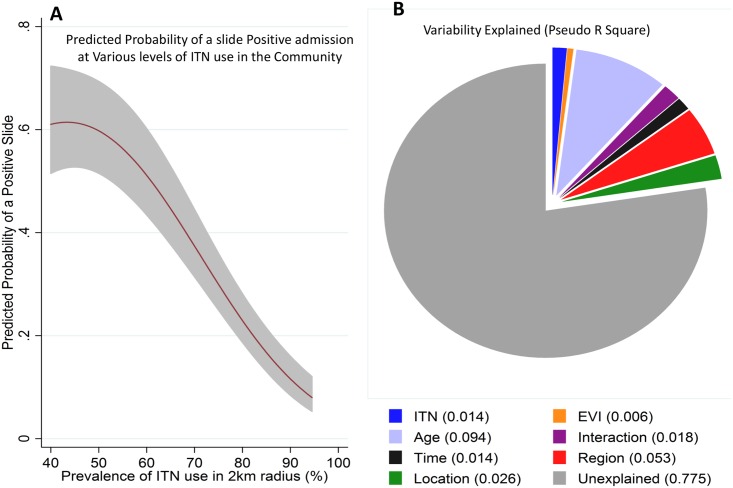
Regression model prediction and variability explained by the predictors of the model.Panel A shows the predicted probability of a positive slide result (y-axis) against the prevalence of ITN use in a 2 km radius around each admitted child’s residence (shaded area represents 95% CI). Panel B shows the pseudo R2 of the various variables assessed in the extended model (ITN use around a child’s residence, EVI, age, age–time interaction, time, region, and location). We repeated our analysis using a cut-off of >2,500 parasites per μl. The same patterns were seen—i.e., a pattern of a postdecline increase in MPF among older children (S6 Fig), and an inverse relationship between MPF and age of malaria (r = −0.63, p < 0.001) and a pattern of protection by community-level ITN use (S7 Fig). These patterns remained statistically significant.